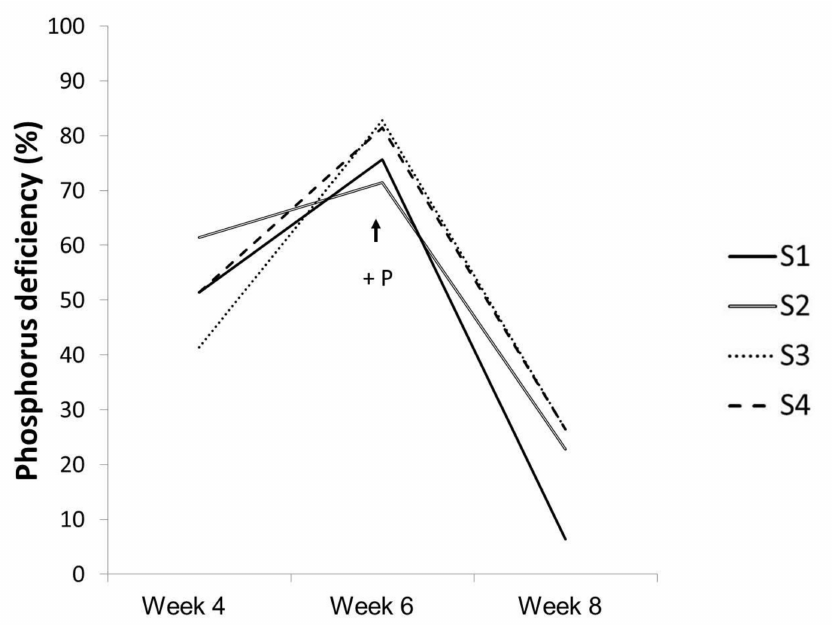
Figure 11. Temporal evolution of the percentage of phosphorus deficiency (purple leaves) in plants from 4 weeks after planting up to 6 and 8 weeks considering only growing substrates (S1: 100% coconut fiber; S2: 66% coconut fiber + 33% bagasse; S3: 50% coconut fiber + 50% bagasse; S4: 33% coconut fiber + 66%